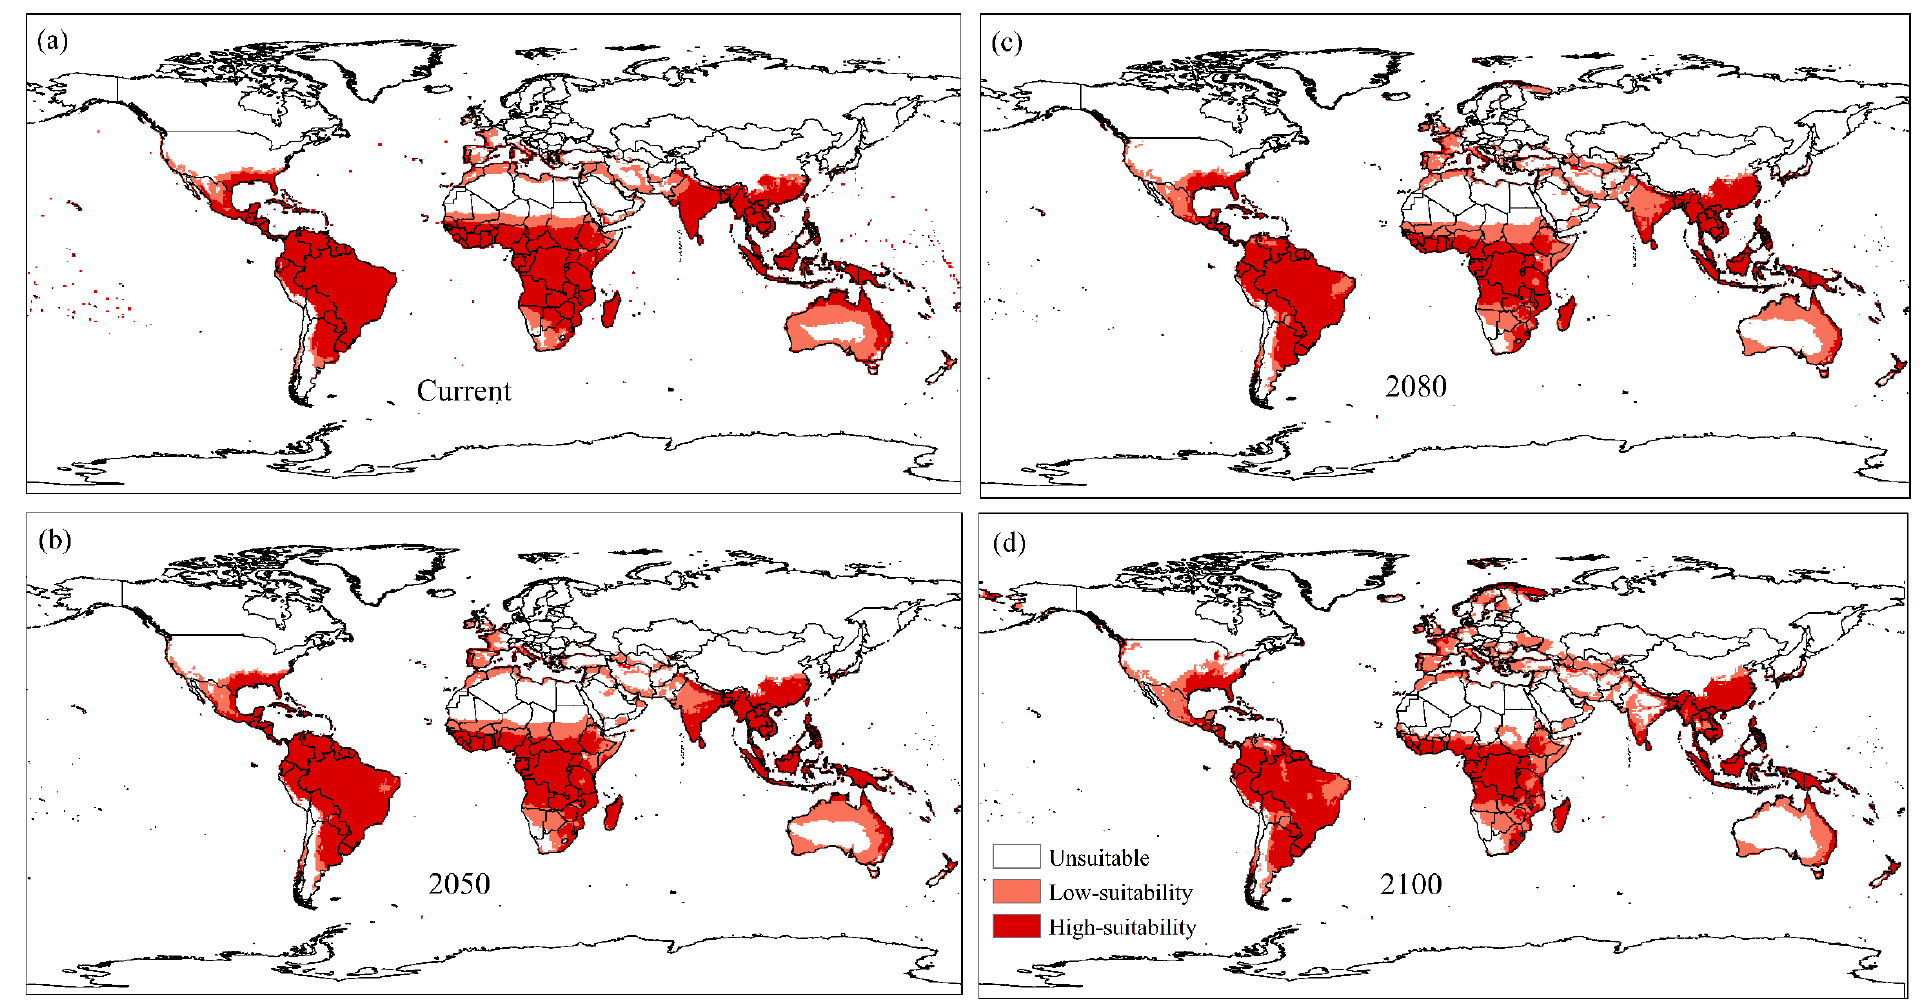
Figure 5. Current ( a ) and projected Ecoclimatic Index (EI) using CLIMEX under CSIRO SRES A2 scenario for the years 2050 ( b ), 2080 ( c ) and, 2100 ( d ), for U. panicoides . Unsuitable areas in white (EI = 0), low-suitability areas in light red (0 < EI < 30), and high-suitability areas in red (30 < EI < 100).